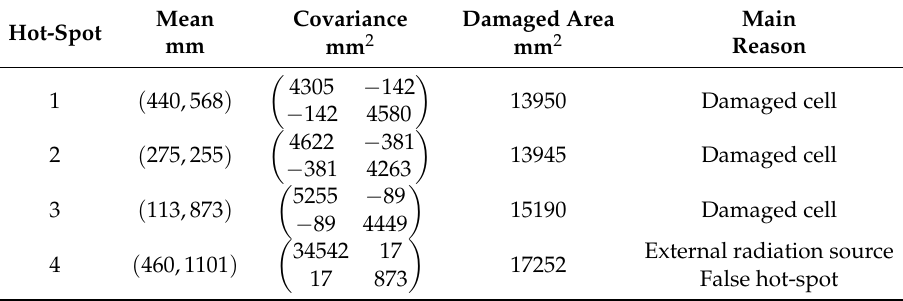
Table 7. Estimated values of detected hot-spots.